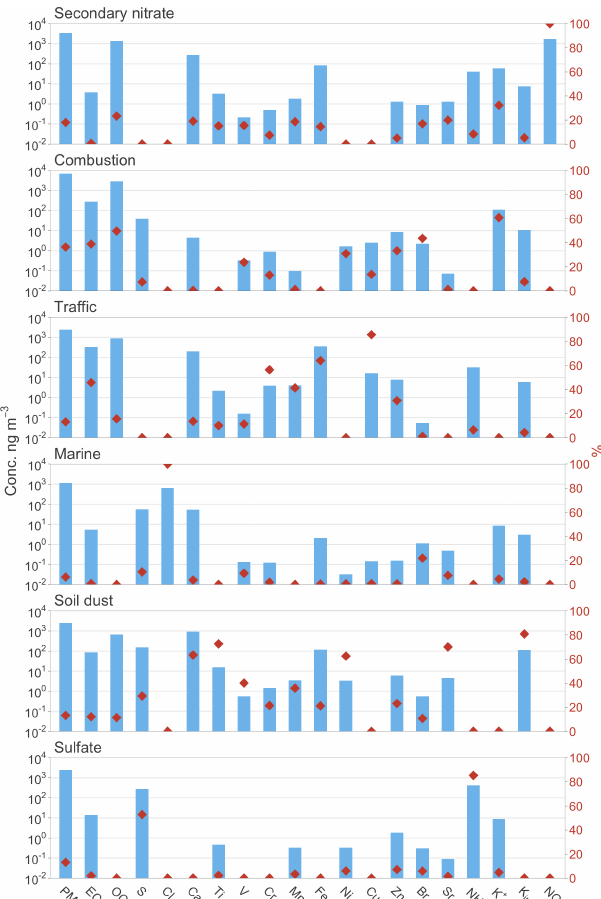
Figure 8. Chemical profiles of the factors obtained by PMF anal- ysis, showing the mass contribution (in ngm − 3 ) of each species within each source (blue bars) and the average percentage contribu- tion of each source to the total concentration of each element (red